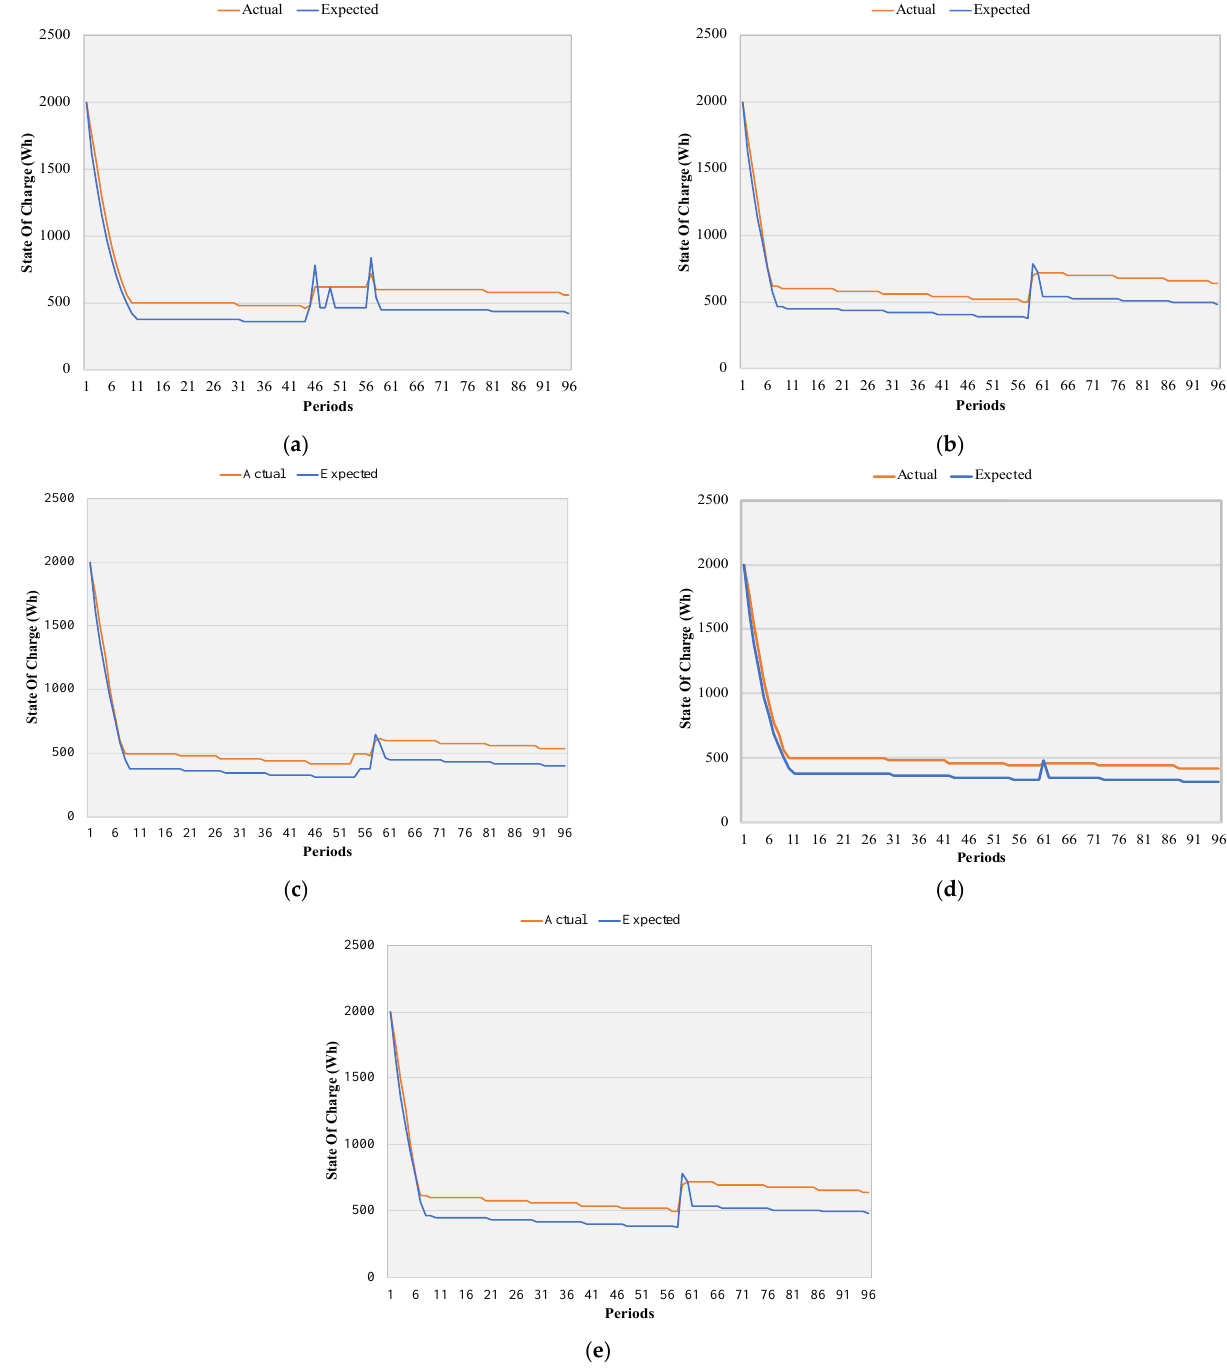
Figure 6. Comparison between the expected and the real state of charge from different batteries: ( a ) battery ID 0, ( b ) battery ID 1, ( c ) battery ID 2, ( d ) battery ID 3, ( e ) battery ID 4.